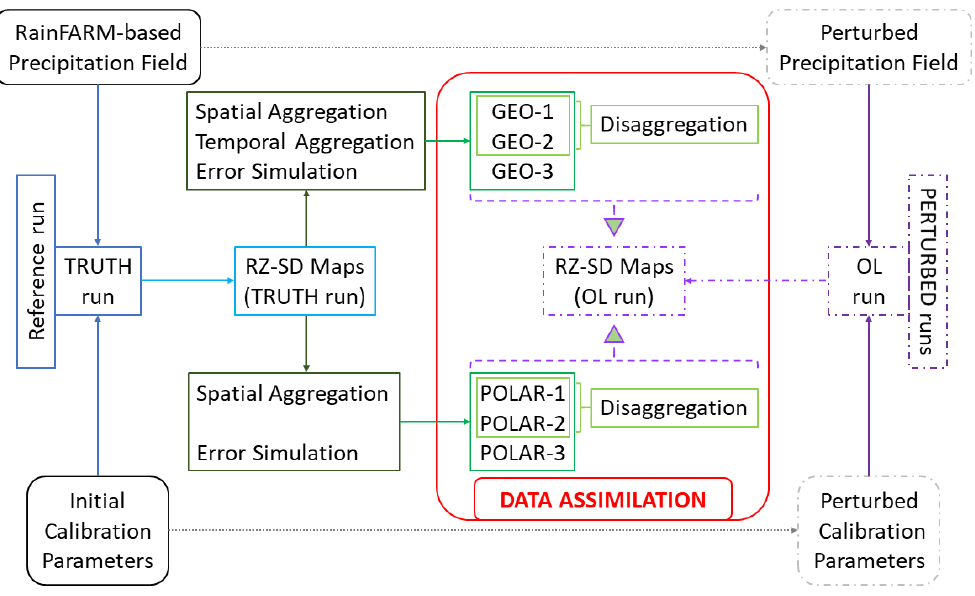
Figure 3. Workflow representing the synthetic SM-DA experiment. Left: the ‘ reference ’ TRUTH run is based on calibration parameters and rain field assumed as the ‘ truth ’, and thus provides the reference discharge and SM maps. Right: set of ‘ PERTURBED ’ runs based on perturbed precipitation data (to account for the sampling by a rain gauge network) and slightly wrong calibration parameters (i.e., perturbed on purpose). The OL run represents the PERTURBED run in which the SM-DA is not carried out (that in turn, in a SM-DA framework, corresponds to a run where the G parameter is set to zero, i.e., the innovation is not taken into account). Middle left: the GEO SAR or POLAR SAR-like SM products are simulated according to different spatio-temporal resolution (GEO-1,2,3 and POLAR-1,2,3), starting from the RZ-SD maps obtained as output of the TRUTH run. The ‘ true ’ SM maps are aggregated in space and time according to the spatio-temporal resolution of the radar, and then perturbed with a random noise to simulate retrieval errors. The middle-right red box represents the SM-DA system in which the SM synthetic observations are assimilated by using different values for the G parameter (0.2, 0.4, 0.6, 0.8 and 1) to carry out a sensitivity analysis. (1) Initially, a ‘ reference ’ model simulation was produced by running the Continuum model using the RainFARM-based high-resolution precipitation field as one of the inputs (this is the TRUTH